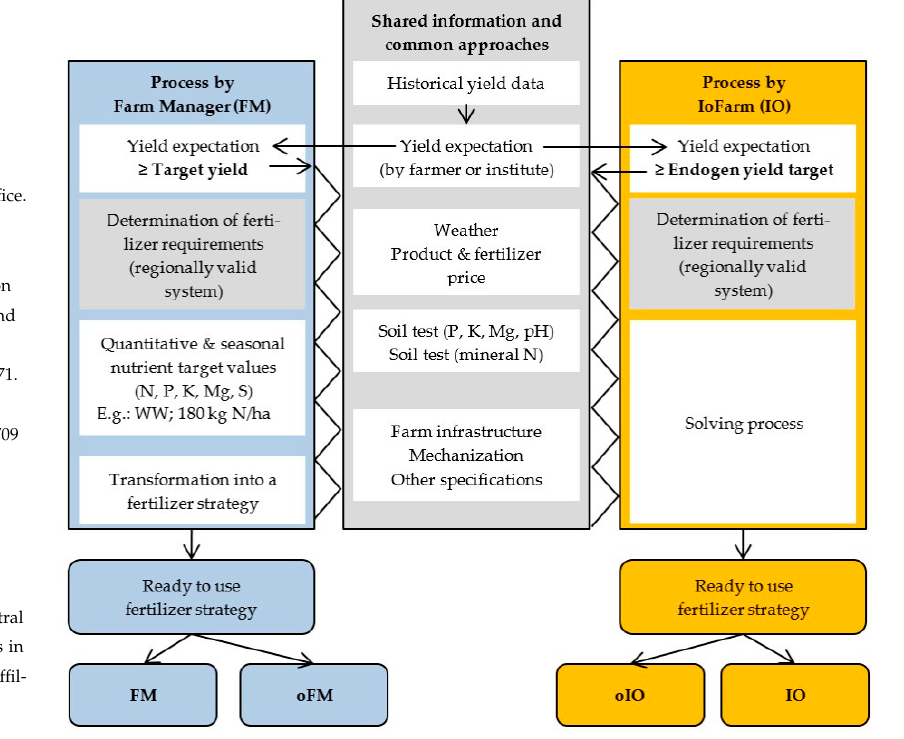
Figure 3. Similarities and differences on the way to a fertilizer strategy: Farm Manager and IoFarm. We apologize for any inconvenience caused and state that the scientific conclusions are unaffected. The original article has been updated.